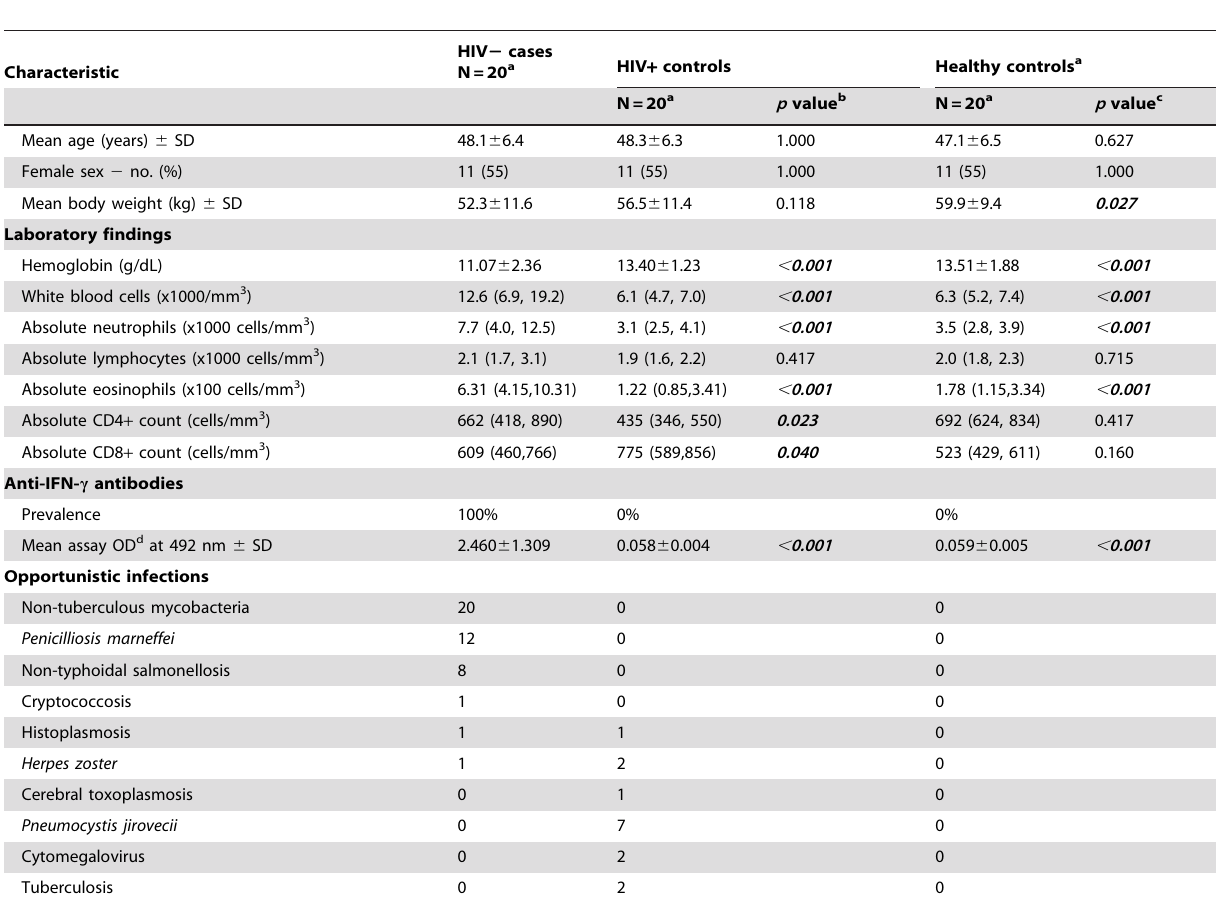
Table 1. Demographic and clinical characteristics of cases of HIV-negative (HIV 2 ) adult-onset immunodeficiency versus HIV- infected (HIV + ) and healthy controls (from reference